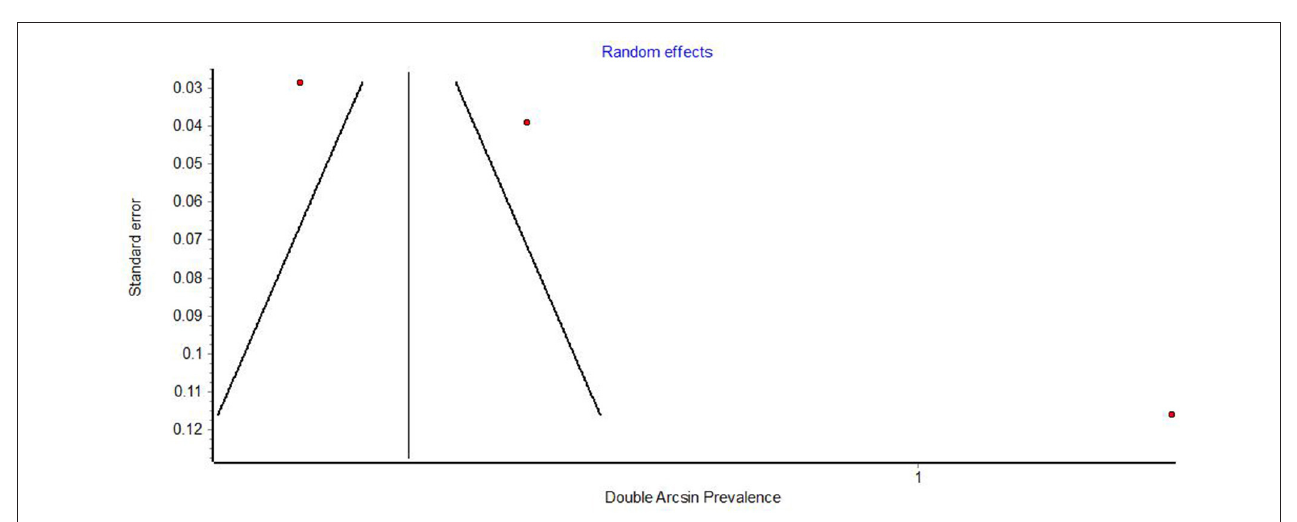
FIGURE 8 | Funnel plot of studies on the prevalence of aphthous lesions.